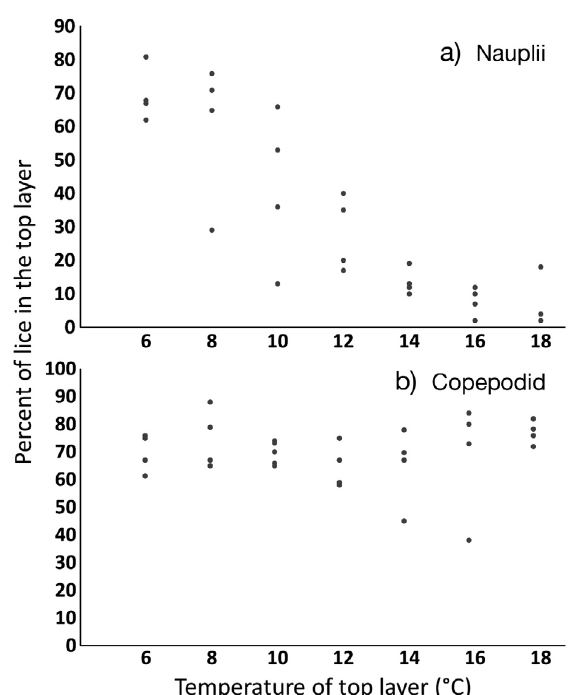
Fig. 2. Proportion of (a) nauplii and (b) copepodids of Lep- eophtheirus salmonis in the layer above the step tempera- ture gradient as a function of the temperature in the over - lying layer. Each point represents the proportion of lice in the top layer for a column replicate. The 12°C treatment served as an isothermal control (12°C in both the top and bottom layers of the